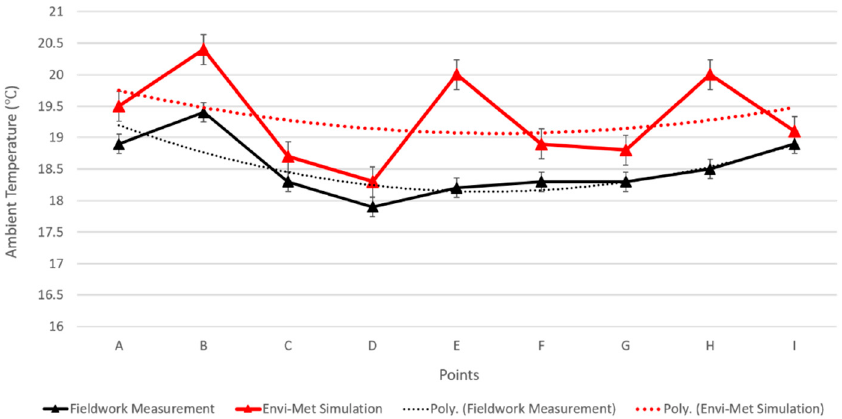
Figure 3. Comparison of ambient temperature recorded at field measurement with simulations in track 1.